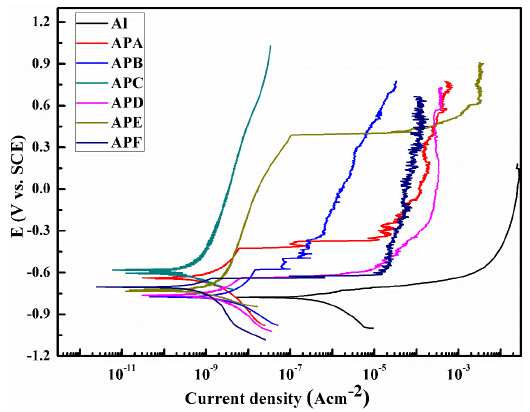
Figure 12. Potentiodynamic polarization curves of PEO coatings and pure aluminum sample. Table 4. Corrosion properties of pure aluminum and PEO coatings.